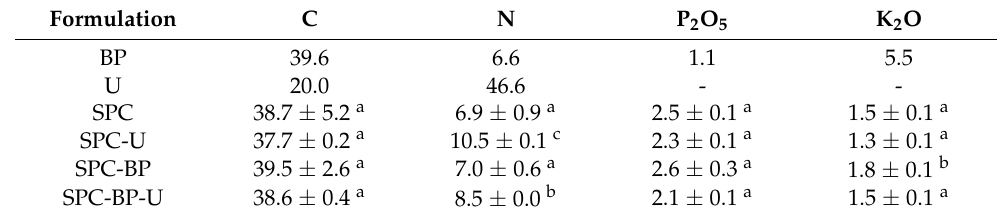
Table 1. Total C, N, P, and K concentrations (%, w w − 1 ) in neat SPC, BP, urea (U), and in the SPC pellets’ samples 1